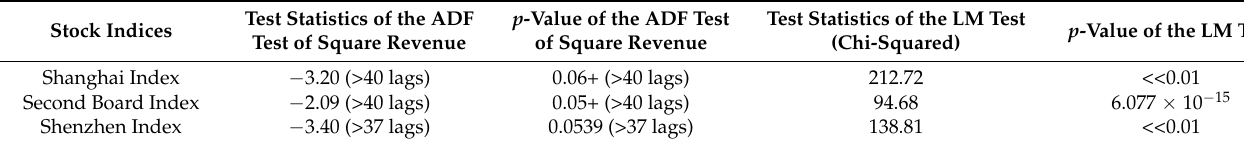
Table 9. The result of the ADF test of daily revenue, square sequence and of the LM test.